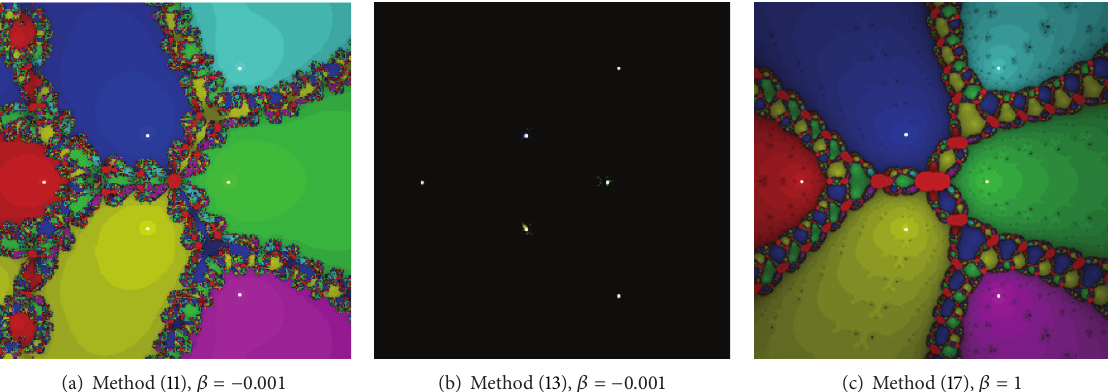
Figure 20: Basins of attraction of (11), (13), and (15) for the test problem 2.